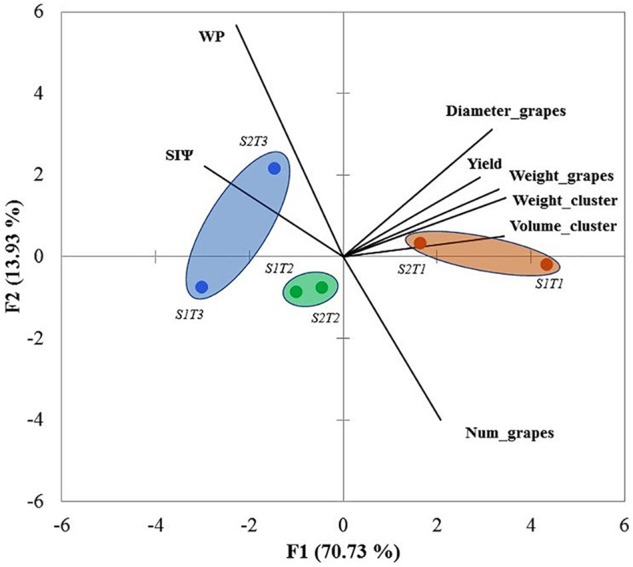
Principal component analysis (PCA) considering all data sets for the growing seasons 2011/2012 and 2012/2013 (cv. Carménère). SIΨ, integral water stress; WP, water productivity; Diameter_grape, diameter of grape; Weight_cluster, weight of cluster; Weight_grape, weight of grape; Volume_cluster, volume of cluster; Num_grapes, number of grapes; S1 = season 2011/12 and S2 = season 2012/13. T1, T2, and T3 are the irrigation treatments.